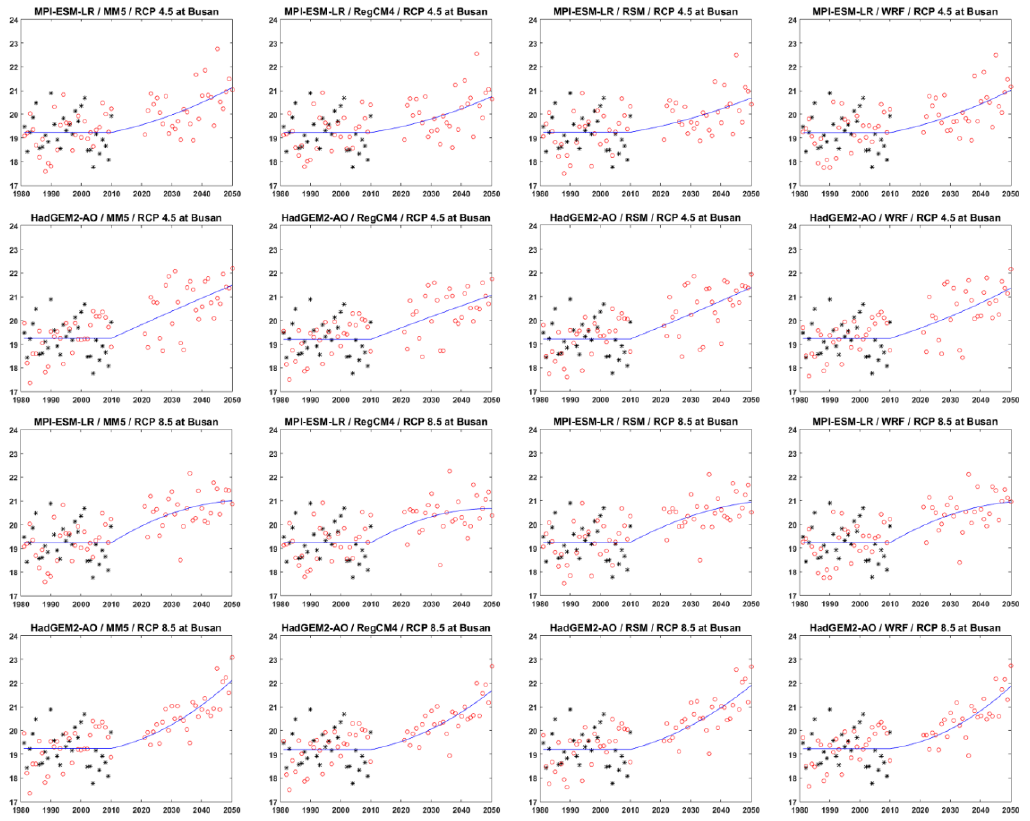
Figure 10. Yearly DPT time series at Busan site.